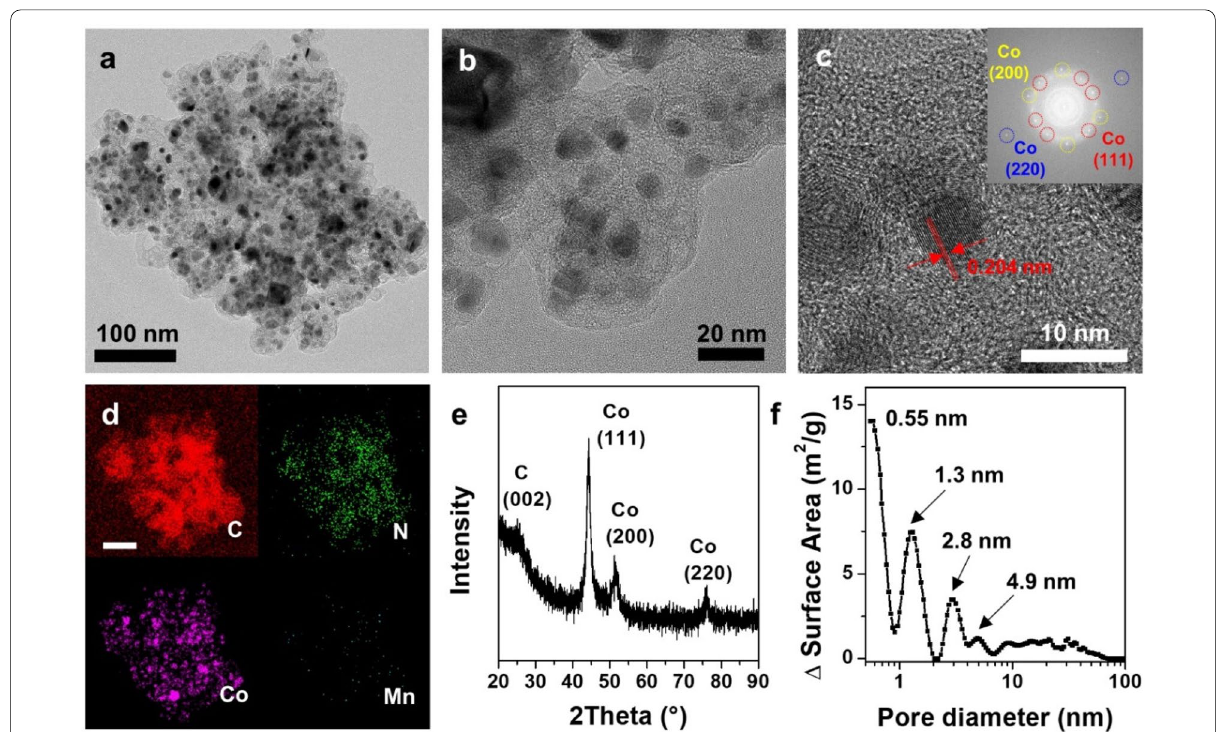
Fig. 2 Structural analysis of MnCo‑NCF after annealing. a, b TEM, c HR‑TEM (inset: FFT pattern), and d Elemental mapping images of MnCo‑NCF. e Powder XRD pattern and f Pore size distribution of MnCo‑NCF after